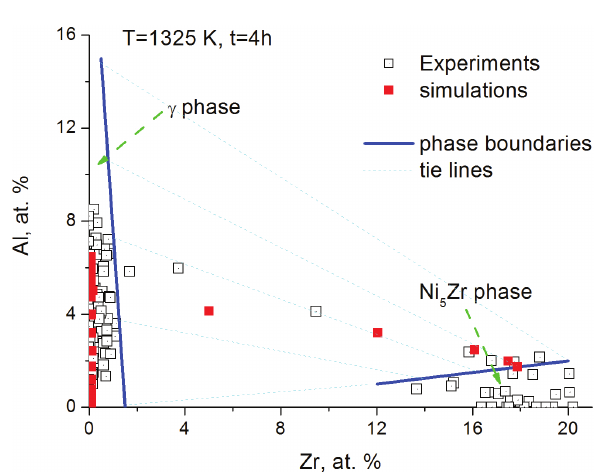
Fig. 9: The part of the Ni-Al-Zr phase diagram [38] at 1325 K. Two phases can be distinguished: γ -Ni and Ni 5 Zr phase. The comparison of the experimental (empty dots) and computational (full dots) diffusion